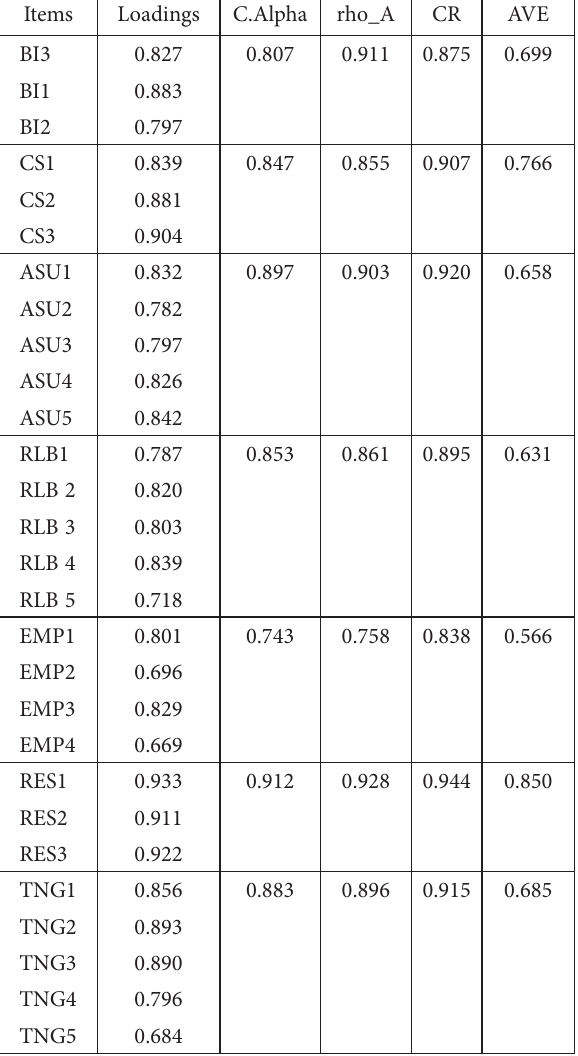
Table 2. Measurement model assessment